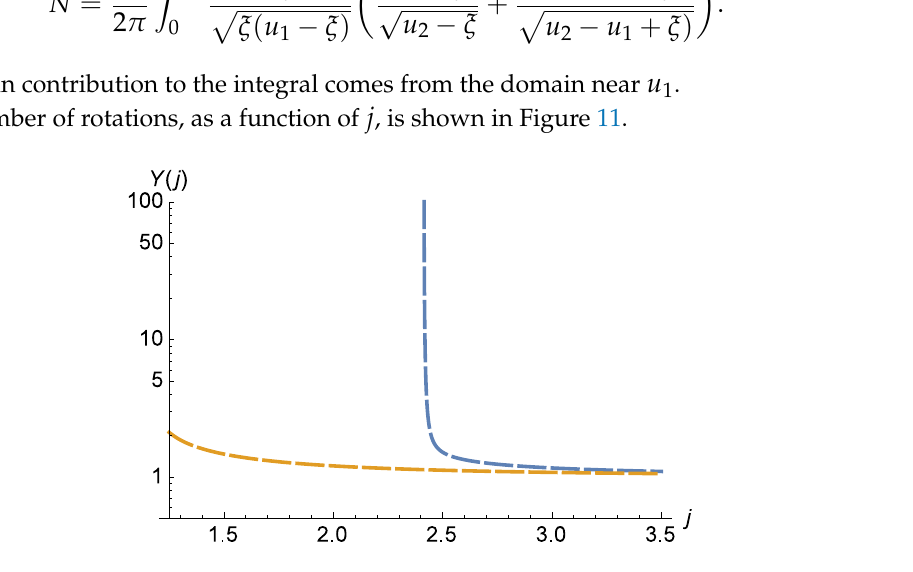
Figure 11. Number of turns N as function of specific angular momentum j when test body travels in the vicinity of fast-spinning black hole, shown for two rotation regimes, a = − 0.5 (retrograde, right curve) and a = + 0.5 (prograde, left